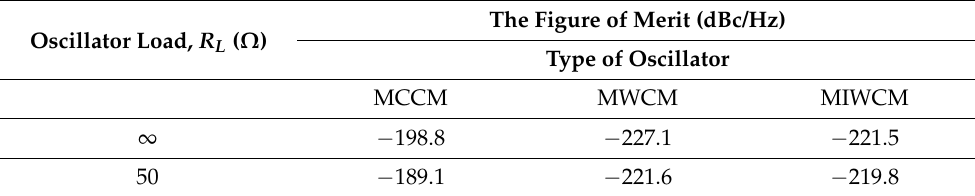
Table 10. Performance comparison of oscillators with different